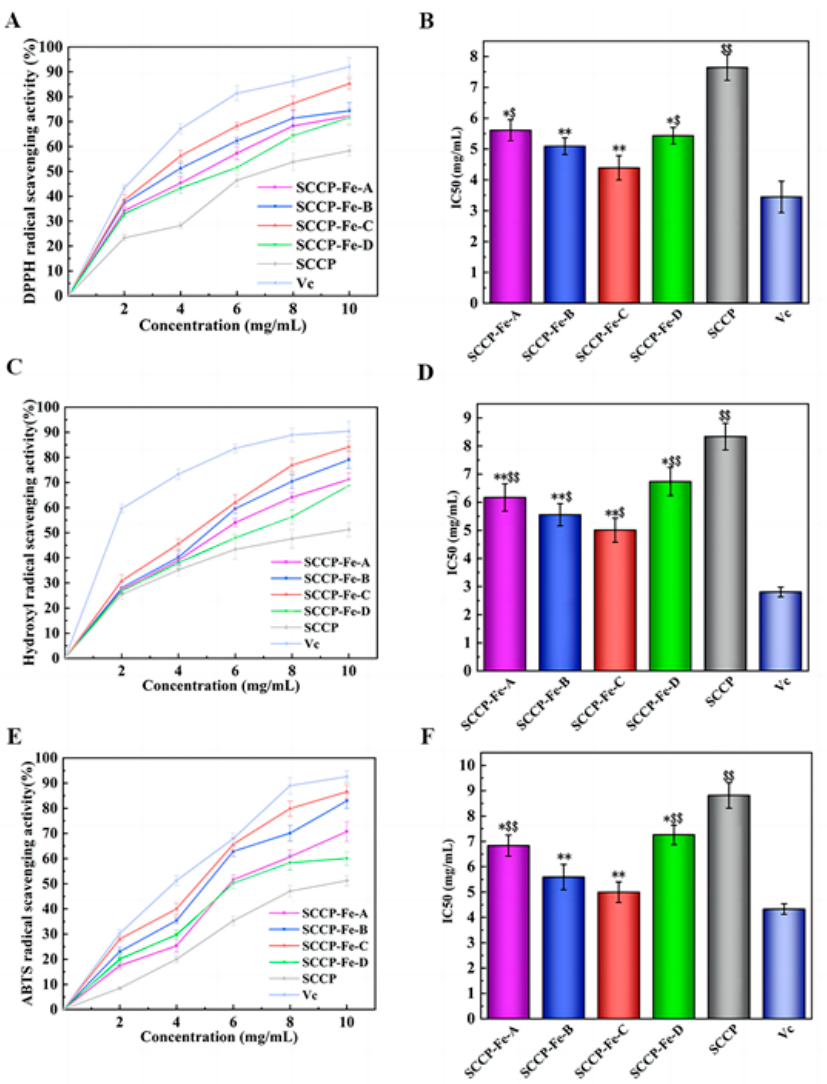
Figure 7. Antioxidant activity of four sweet corn cob polysaccharide-iron (III) complexes. (( A , B ): DPPH radical-scavenging activity and its half-inhibition concentration (IC 50 ); ( C , D ): hydroxyl radical scavenging activity and its IC 50 ; ( E , F ): ABTS radical-scavenging activity and its IC 50 ; *: p < 0.05 compared to SCCP; **: p < 0.01 compared to SCCP; $: p < 0.05 compared to Vc; $$: p < 0.01 compared to Vc.).